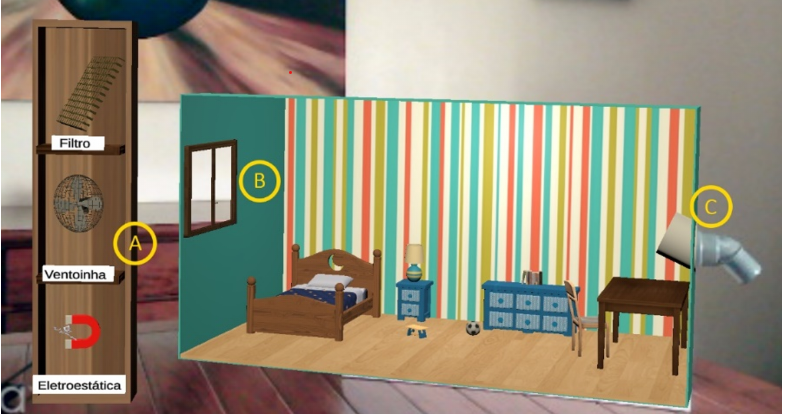
Figure 6. Virtual toolbox and sensor box. A—toolbox; B—particle and gas extraction window; and C—sensor air inlet.